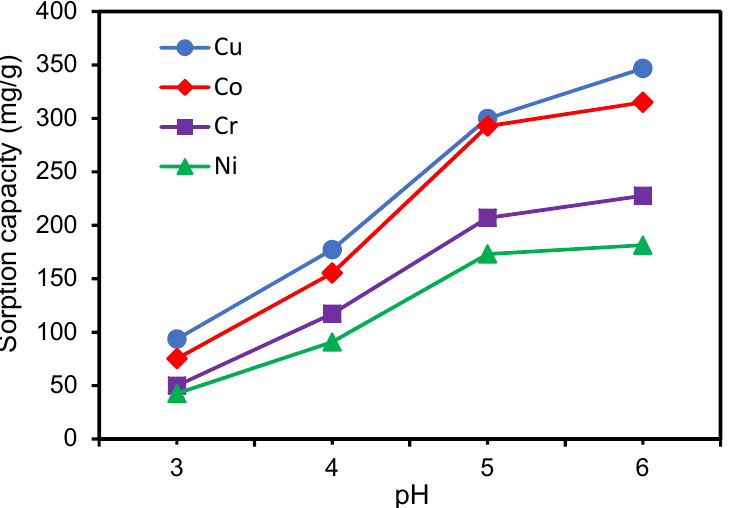
Figure 8. The plot of sorption capacity versus various pH by poly(hydroxamic acid); experimental conditions: 100 mg of dried poly(hydroxamic acid), 10 mL of 0.1 M CH 3 COONa buffer solution at pH 3–6, and 5 mL of 0.1 M heavy metal ion solutions agitated for 2 h.